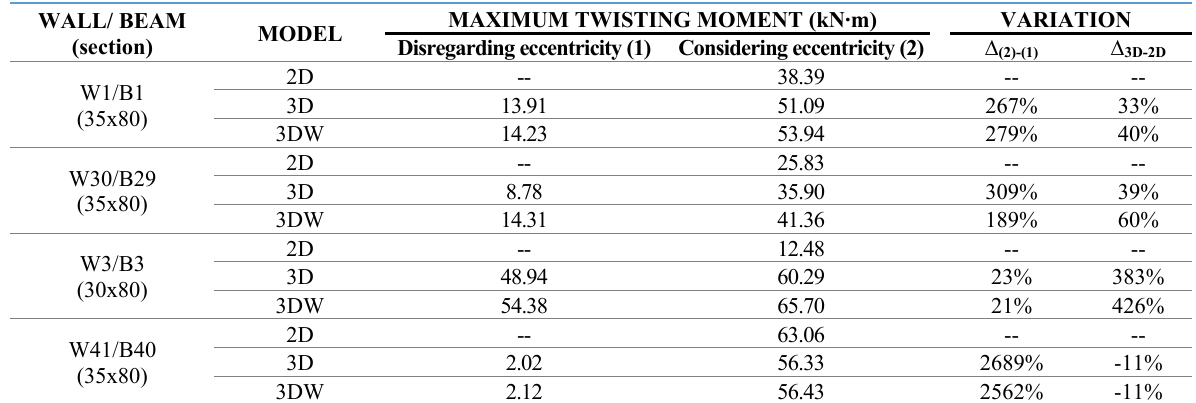
Table 11. Intensities and maximum twisting moments in the support